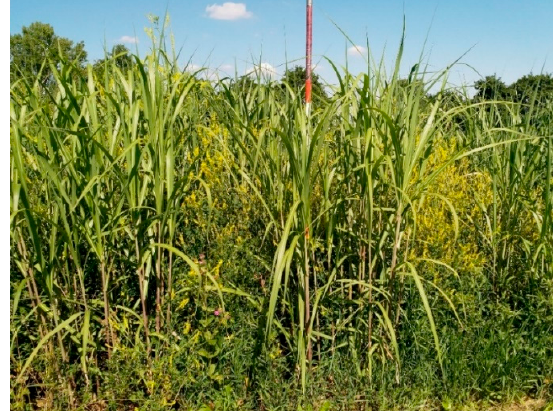
Figure 5. Plant stand of treatment yellow melilot and miscanthus (YAM) during the vegetation period in 2018. Picture taken on 8 June 2018.